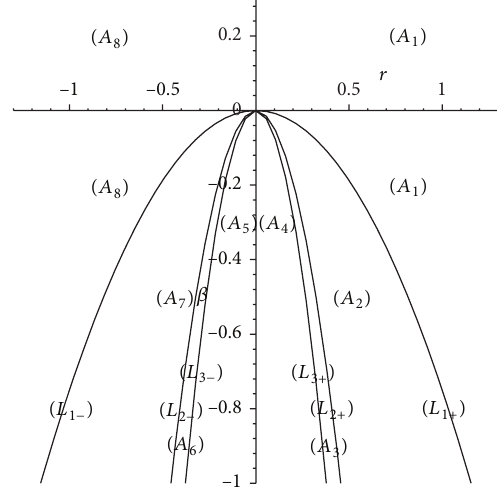
Figure 1: The bifurcation set of system (8) in (𝑟, 𝛽) -parameter plane for 𝛼 < 0